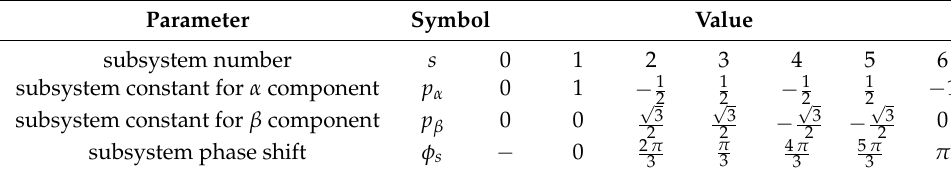
Table A1. Subsystem constants and phase